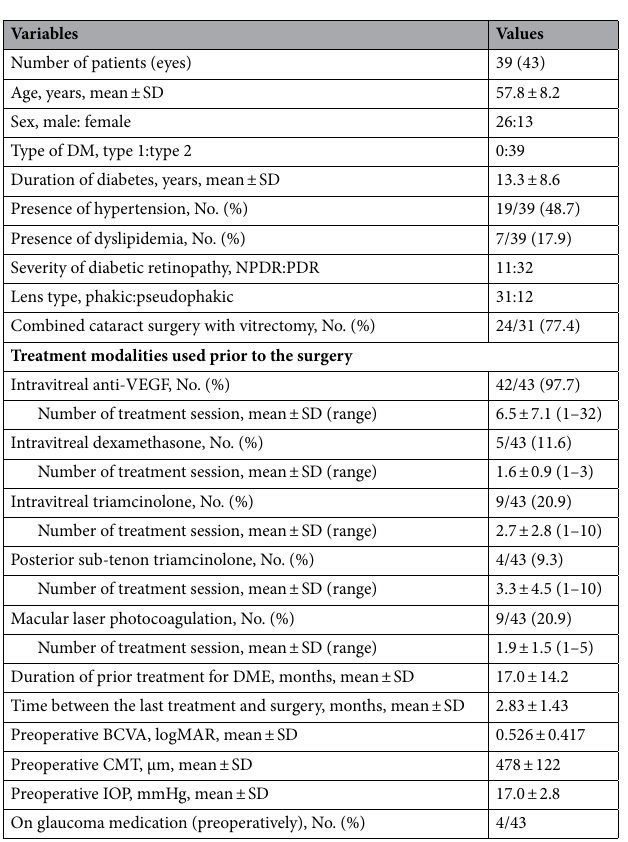
Table 1. Baseline demographics and clinical characteristics of subjects with diabetic macular edema refractory to prior treatments. SD, standard deviation; DM, diabetes mellitus; NPDR, non-proliferative diabetic retinopathy; PDR, proliferative diabetic retinopathy; DME, diabetic macular edema; VEGF, vascular endothelial growth factor; BCVA, best-corrected visual acuity; logMAR, logarithm of the minimal angle of resolution; CMT, central macular thickness; IOP, intraocular